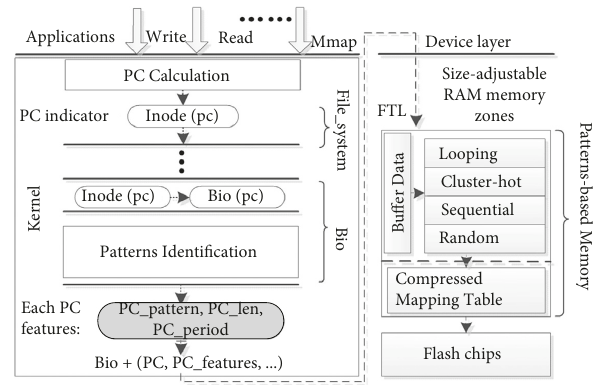
Figure 1: Overall architecture of